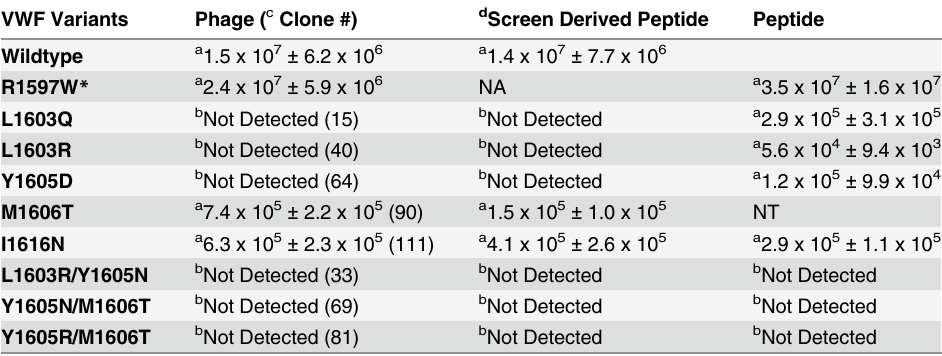
Table 3. Phage and VWF73 peptide enzyme kinetics K cat /K M (M -1 min -1 ). VWF